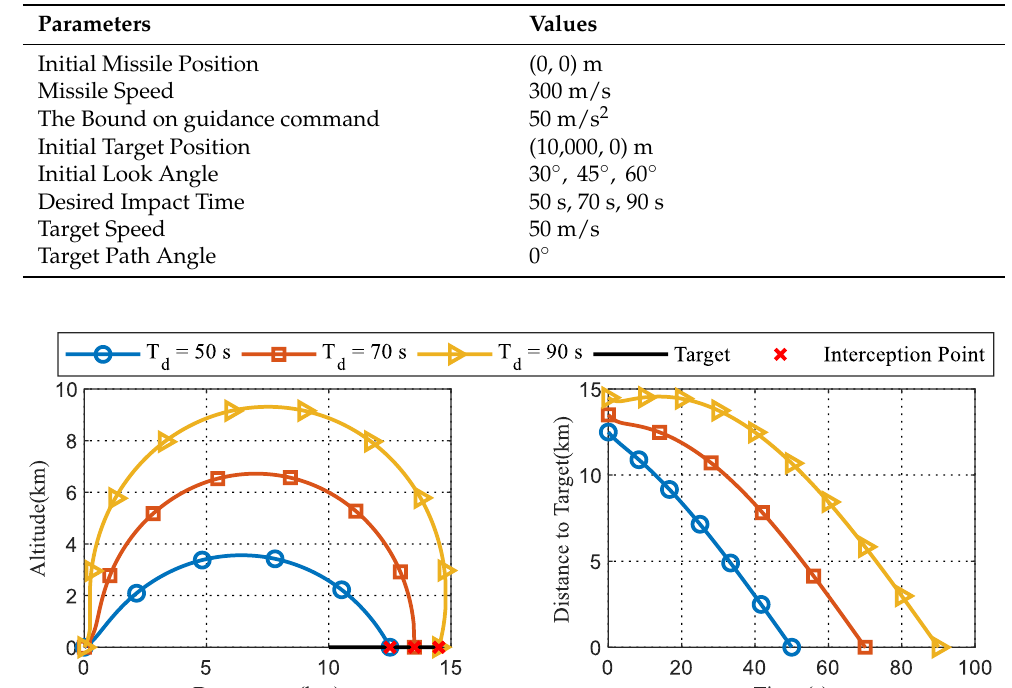
Table 5. Parameter values for a moving target.